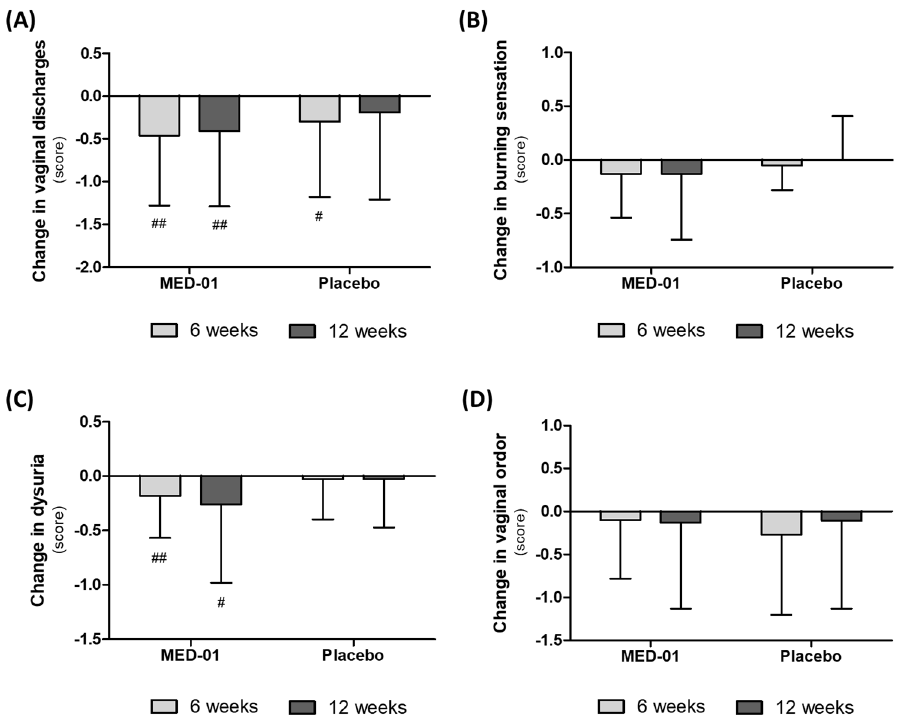
Figure 3. Effect of MED-01on the vaginal symptoms evaluated by the questionnaire evaluation from baseline to 12 weeks. Change in ( A ) vaginal discharges, ( B ) burning sensation, ( C ) dysuria, and ( D ) vaginal odor. Values are presented as the mean of score ± SD. # p < 0.05 and ## p < 0.01 derived from a paired t -test within groups, Weeks 0 vs. 12.